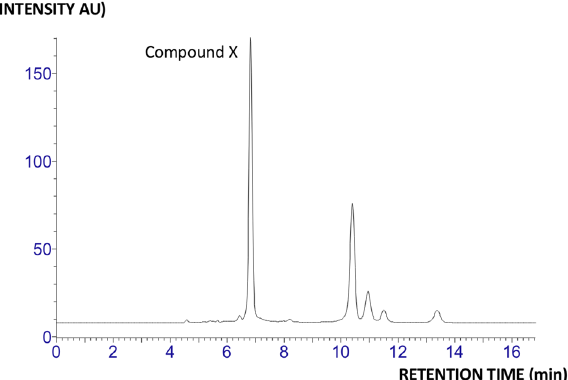
Figure 2. Reversed phase LC chromatography of goose aqueous humor, used for isolation of “compound X”. Conditions are described in “Methods” section (liquid chromatography and spectroscopy).